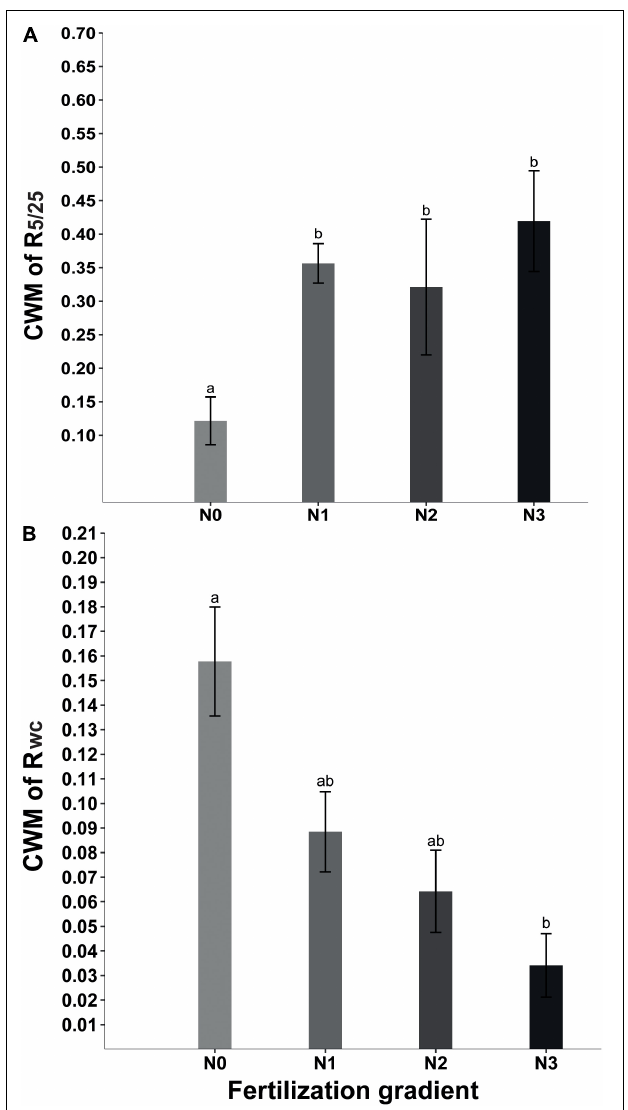
FIGURE 2 | Effect of nitrogen addition (N0, 0 g N m − 2 year − 1 ; N1, 5 g N m − 2 year − 1 ; N2, 10g N m − 2 year − 1 ; N3, 20g N m − 2 year − 1 ) on CWM (community weighted mean) of R 5 / 25 (germination response to temperature fluctuation) (A) and CWM of R wc (germination response to wet-cold storage) (B) . Different letters indicate significant differences ( P < 0.05). Error bars are ± SE.